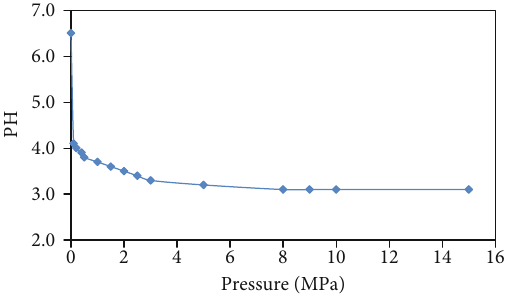
Figure 9: pH of formation water at di ff erent pressures during CO2 injection ( T = 50 °